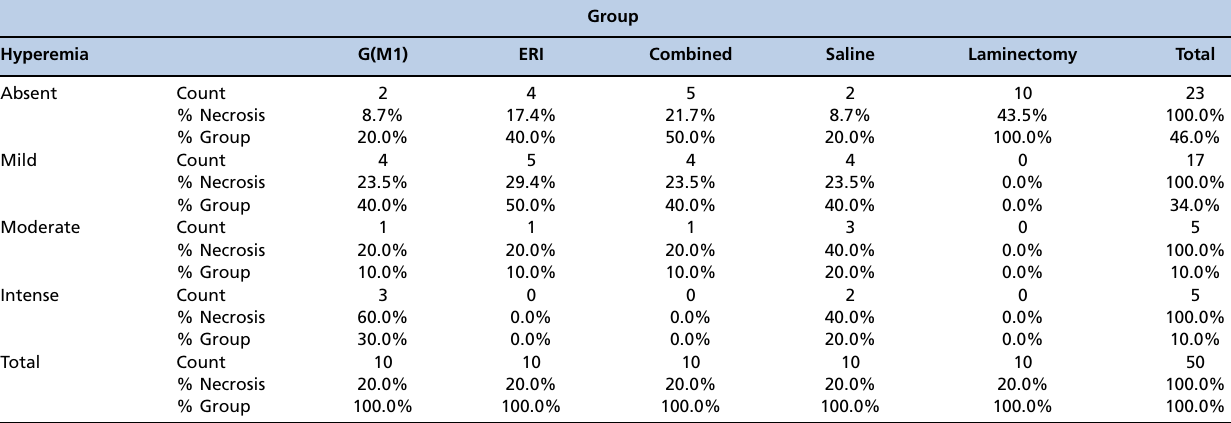
Table 5 - Hyperemia in the distal section of the spinal cord in Wistar rats subjected to experimental spinal cord contusion lesioning.